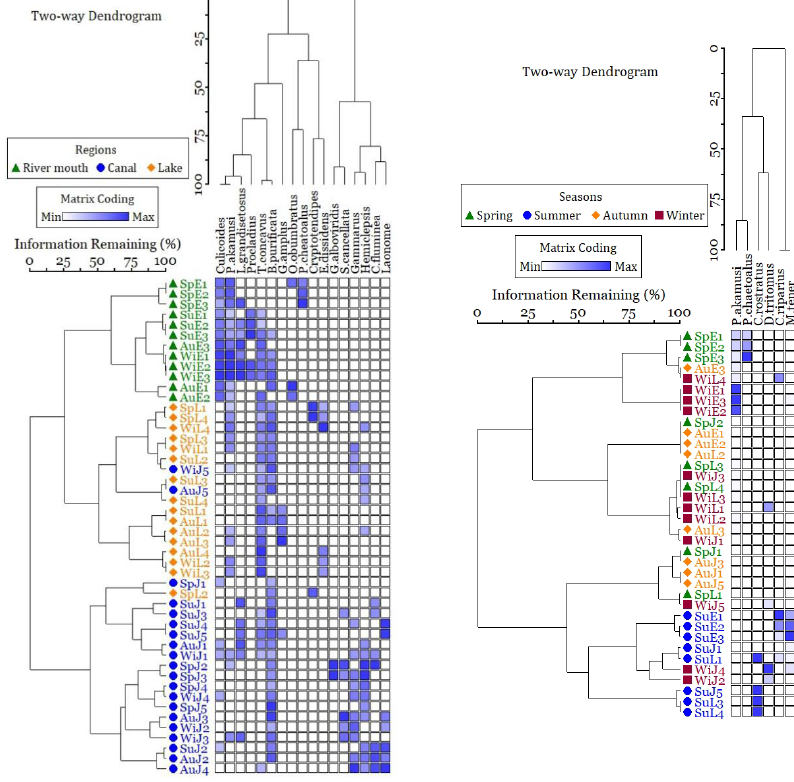
Figure 4. Two-way cluster analysis based on the indicator species among regions and seasons (samples without indicator species were rejected in the analysis).